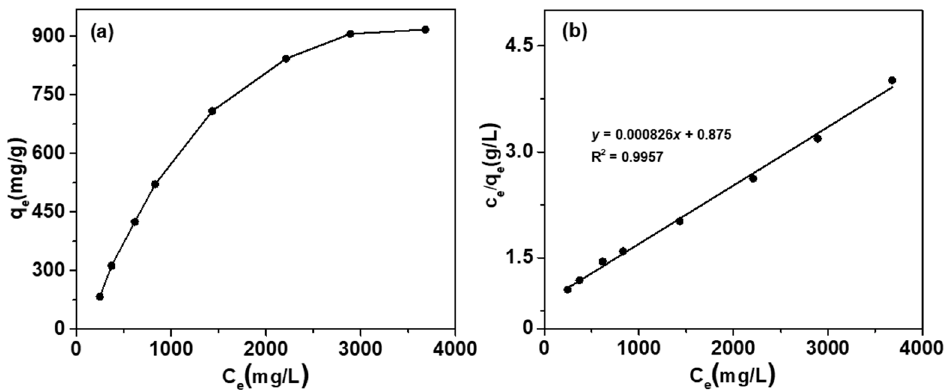
Figure 6. ( a ) Pb 2+ adsorption isotherm by the NUT-21-TETA, ( b ) Linear regression by fitting the equilibrium adsorption data with Langmuir adsorption model. (m = 50 mg, V = 10 mL, T = 25 °C). In addition, NUT-21-TETA demonstrated a rapid adsorption rate and the Pb 2+ uptake reached equilibrium in just 20 min (Figure 7a). The Pb 2+ adsorption kinetics of NUT-21-TETA was investigated and the uptake data were fitted by a pseudo-second-order kinetic model (Figure 7b). An excellent fitting result with quite a high correlation coefficient (R 2 > 0.999) was obtained (Table S3), indicating that the Pb 2+ capture mechanism was chemisorption and the removal rate of Pb 2+ depended on the availability of adsorption active sites [49].